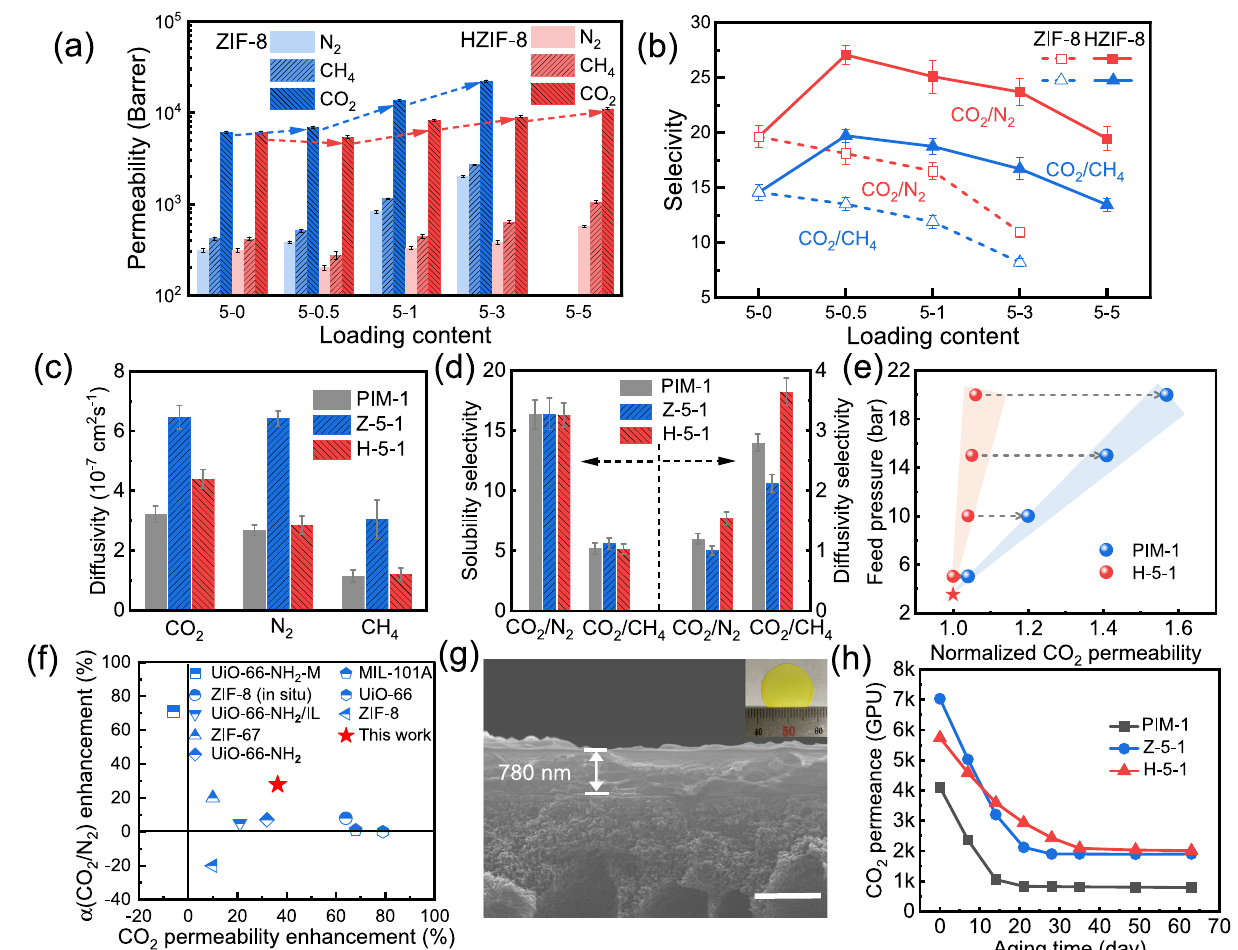
Fig. 3 | Gastransport performance.a , b Gaspermeability( a ) and ideal selectivity ( b )inMMMsasafunctionof fi llercontentat35°Cand3.5bar.Errorbarsrepresent thestandarddeviationsobtainedfromthreemembranes; c , d Diffusivity( c )ofCO 2 , N 2 ,andCH 4 ,andsorptionanddiffusionselectivity( d )ofCO 2 /N 2 ,CO 2 /CH 4 inPIM-1, Z-5-1, and H-5-1. Error bars represent the standard deviations obtained from three membranes; e Normalized CO 2 permeability of PIM-1 and H-5-1 membranes with CO 2 feed pressure increasing from 3.5 to 20bar; f Comparison of the CO 2 per- meability versus CO 2 /N 2 selectivity improvement for PIM-1/MOF MMMs in the